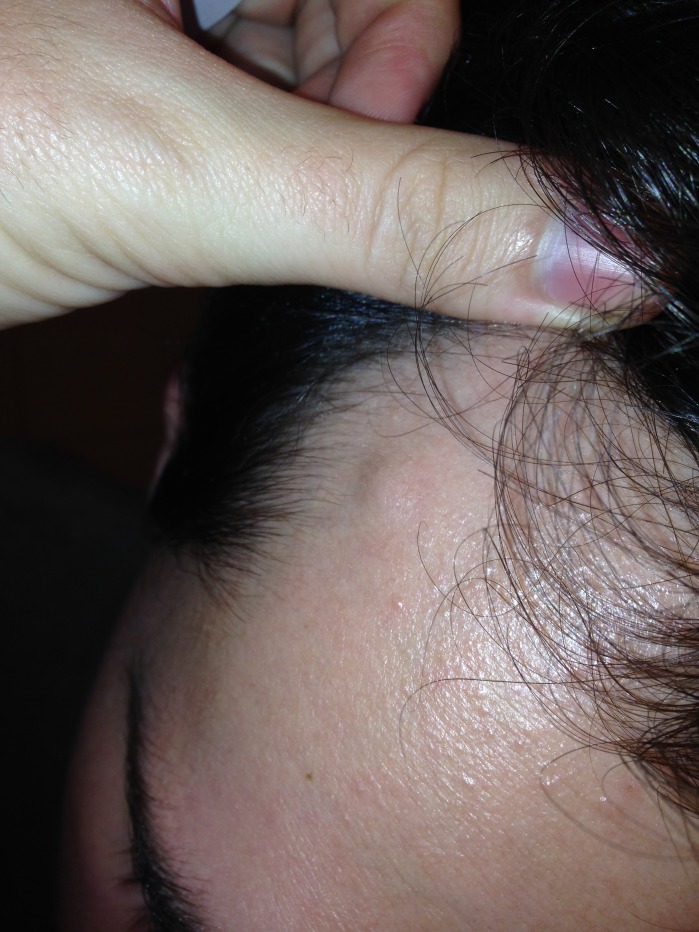
Protuberance in the right temporal region.